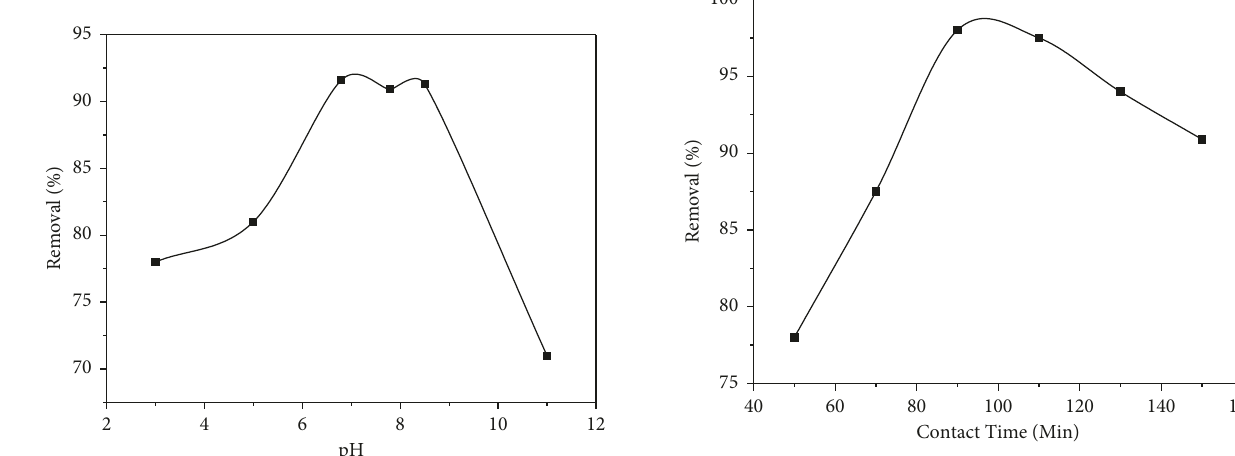
Figure 9: Effect of contact time on fluoride adsorption.